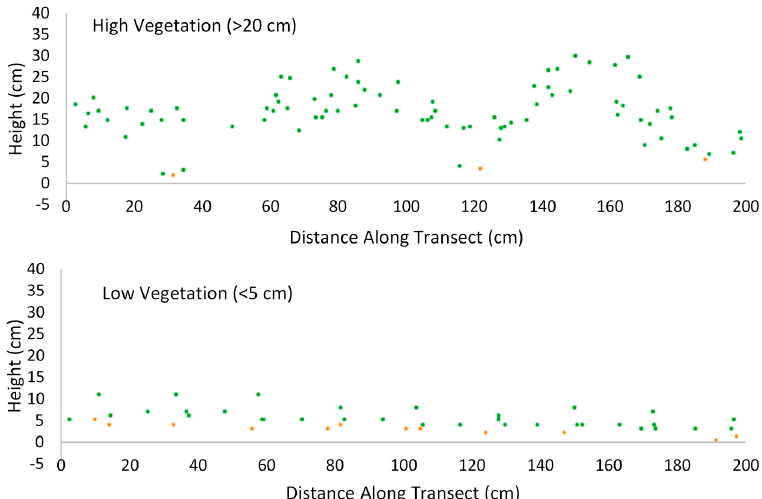
Figure 5. Examples of two grassland canopy transects. The top panel shows data from a high vegetation area. The bottom panel shows data from a low vegetation area. The ground points are shown in yellow color. The canopy points are shown in green color. The transect depth is 0.5 m.